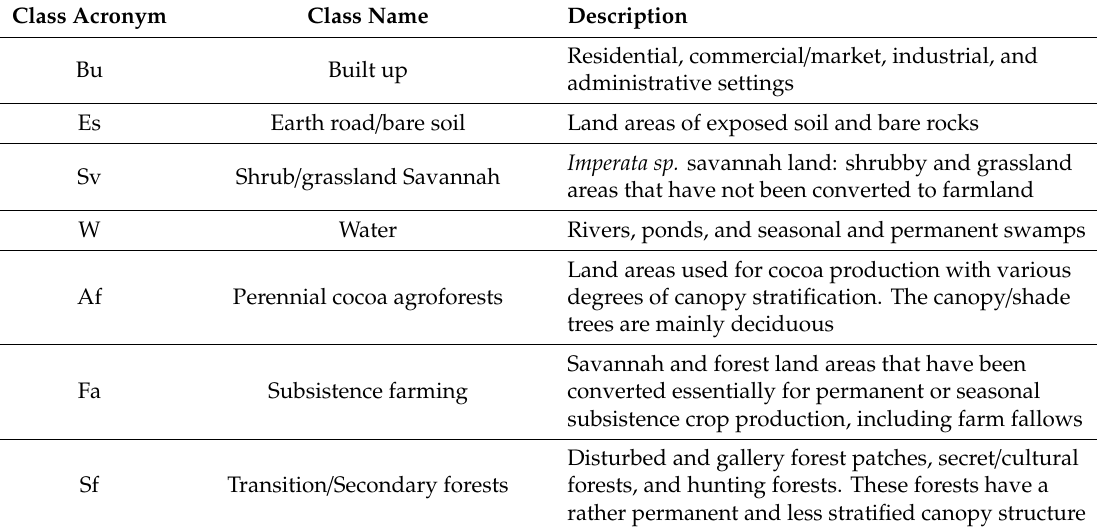
Figure 2. The range of vegetation land cover differs mainly in the density of the woody biomass, which changes with the season or the phenological period. The class abbreviations are described in Table 2 (Source: author). Table 2. A description of the thematic land cover types used for the classification of land cover (Figure